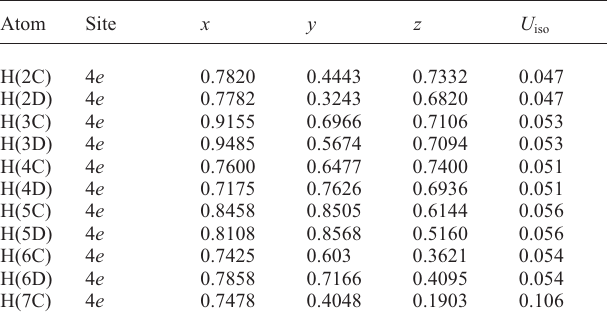
Table 2. Atomic coordinates and displacement parameters (in Å 2 ) .